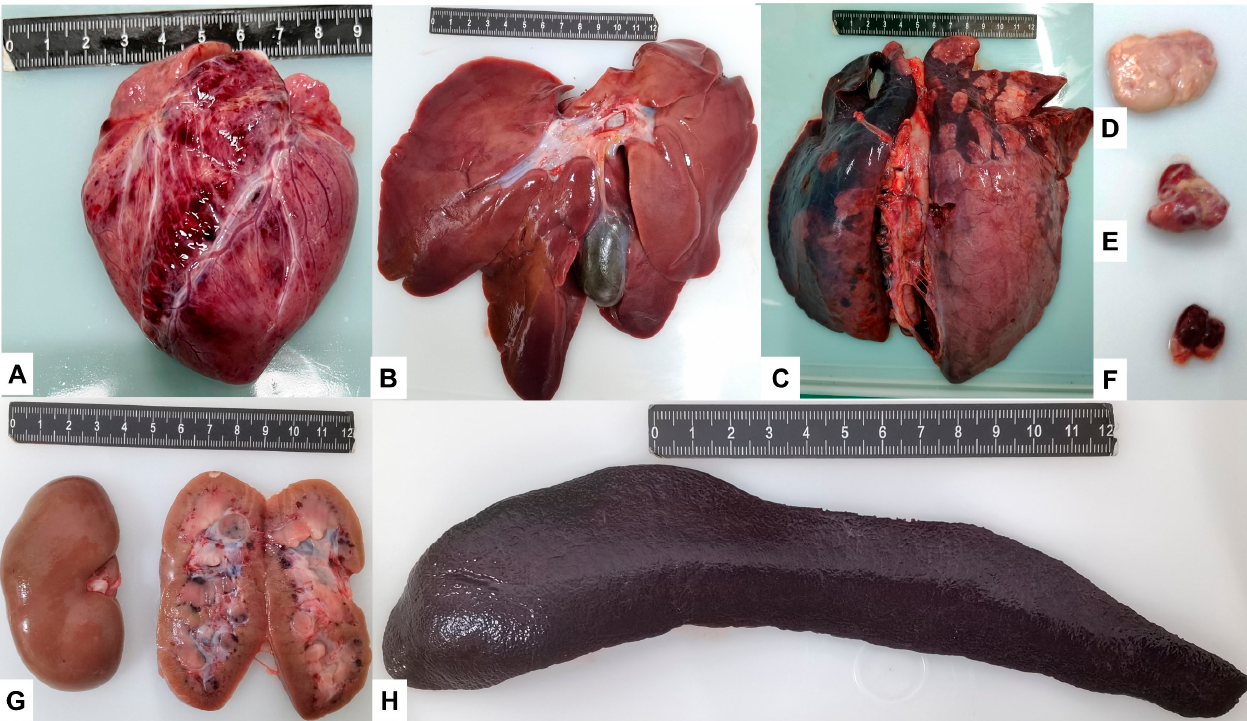
Figure 4. Gross lesions at autopsy. ( A ) Heart with myocardial haemorrhage from pig No. IN200-2; ( B ) Enlarged and hardened liver from pig No. IM200-1; ( C ) Necrotic lung from pig No. IO40-3; ( D – F ) Enlarged and necrotic inguinal lymph nodes, submandibular lymph nodes, and thymus from pig No. IO5000-1; ( G ) Kidney with bleeding spots from pig No. IM200-2; ( H ) Severely enlarged spleen from pig No. IO200-2.